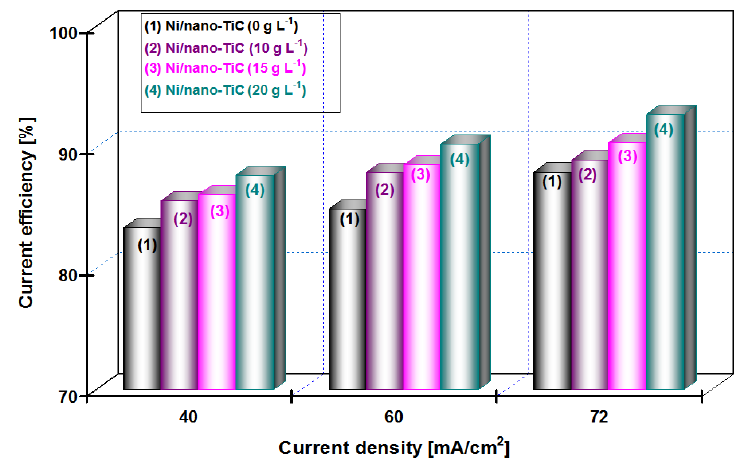
Figure 9. Current efficiency versus applied current densities at different concentrations of nano TiC particles added to nickel electrolyte at deposition time of 15 min.